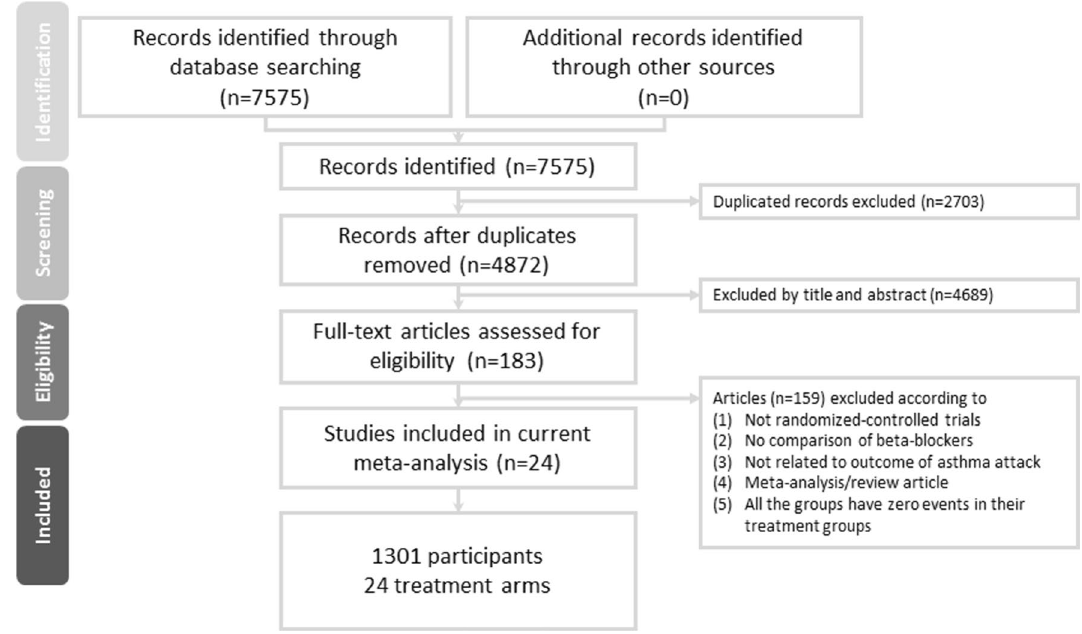
Figure 1. Flowchart of the current network